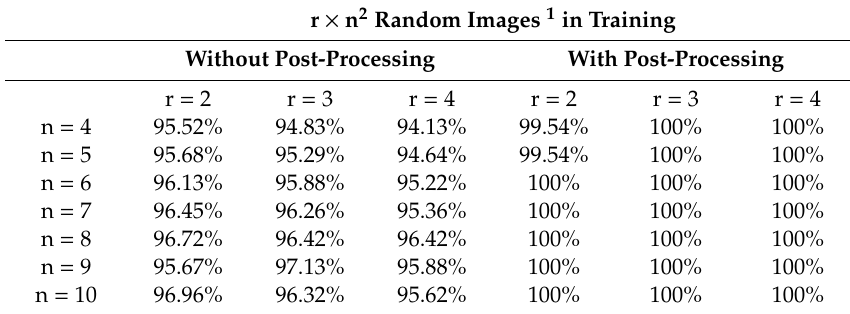
Table 3. Classification results of the experiment on the Vistex database for the set of 54 images. The best results reached with and without post-processing are highlighted by bold text.